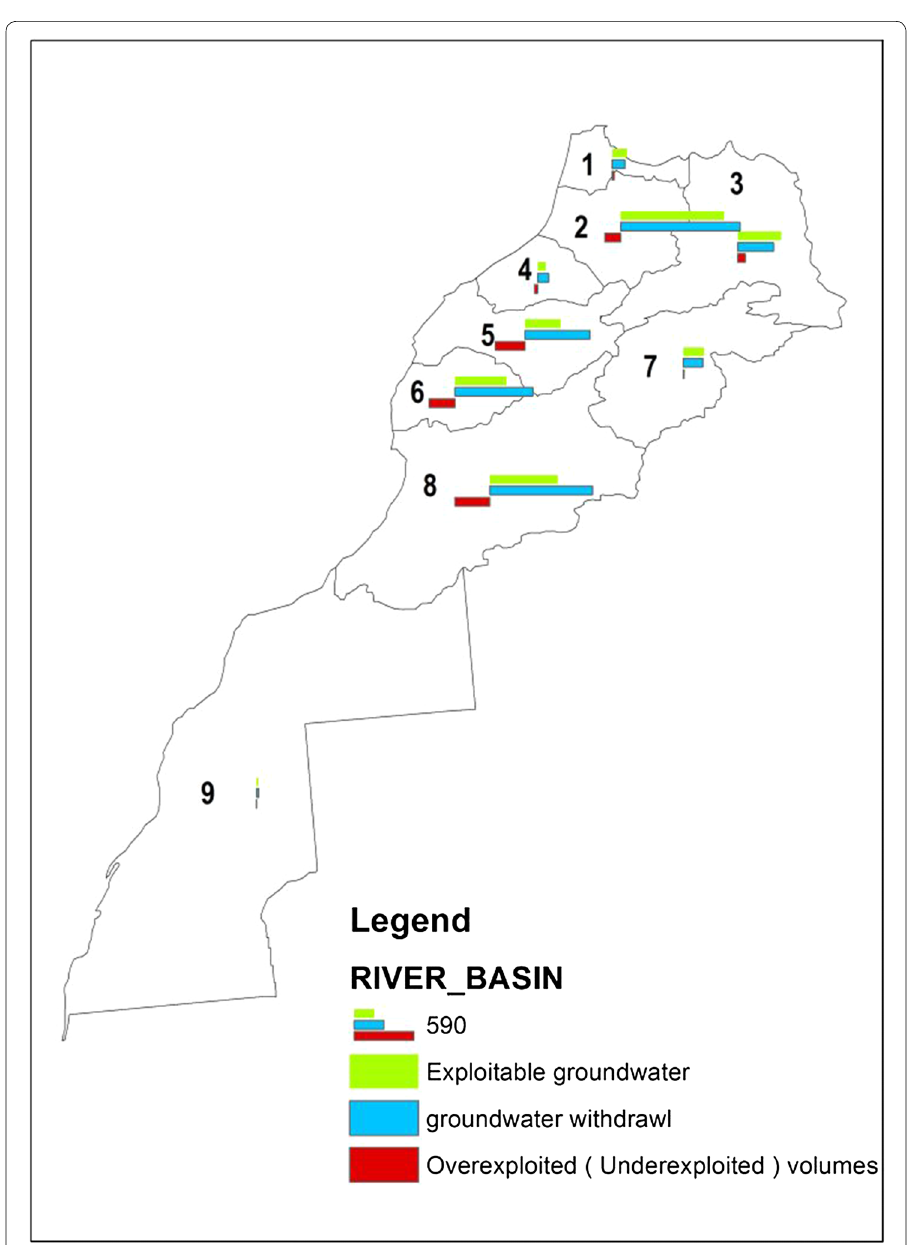
Fig. 3 Distribution of the overexploited groundwater resources volumes. Source : created by the authors. Data extracted from MEMWE